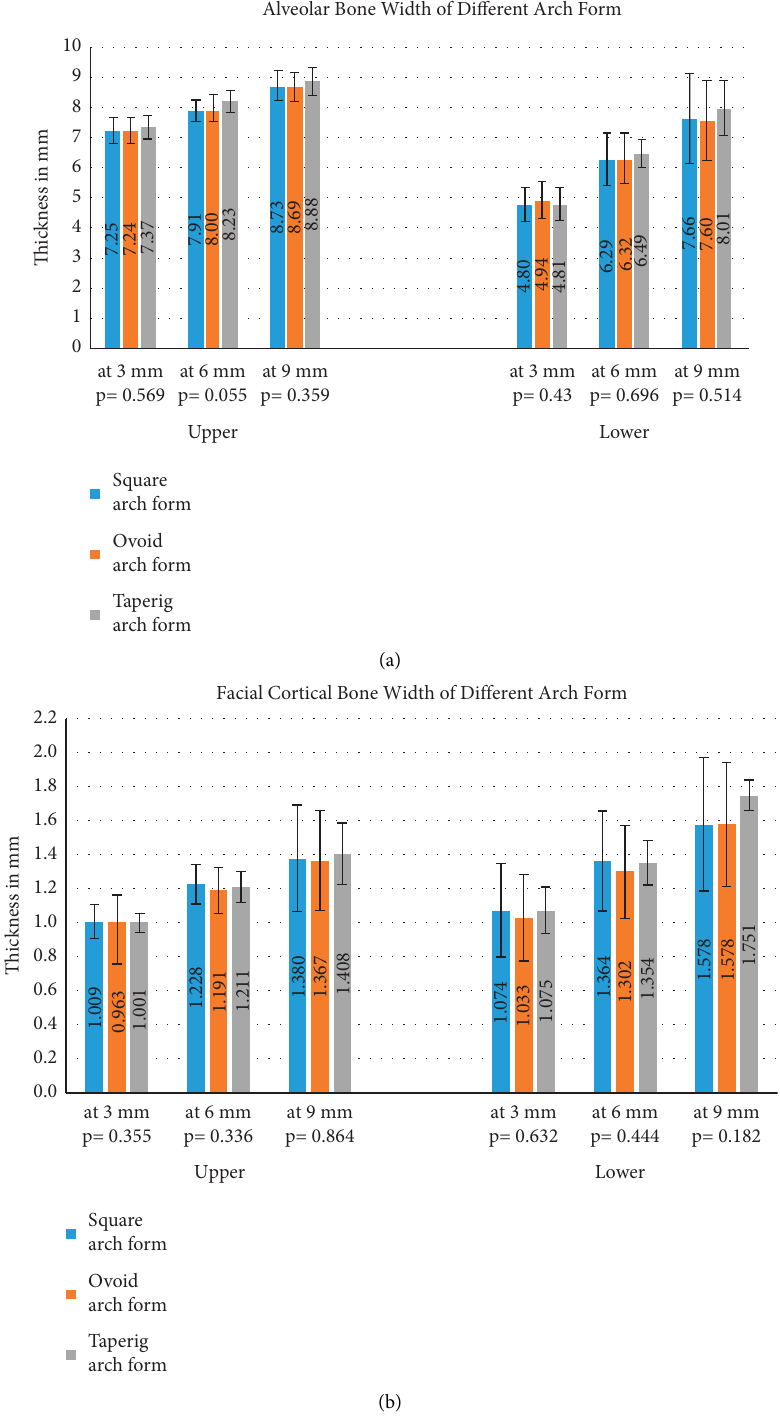
Figure 5: Bone width in millimeters of the upper and lower central incisors (both sides) at 3 levels according to the arch form type. Error bars represent the standard deviations. P values represent the signifcance between the three-level point measurements in the same arch form group type. P values on the X -axis represent the signifcance between alveolar bone width measurements at the same level and the same arch. (a) Alveolar bone width and (b) facial cortical bone